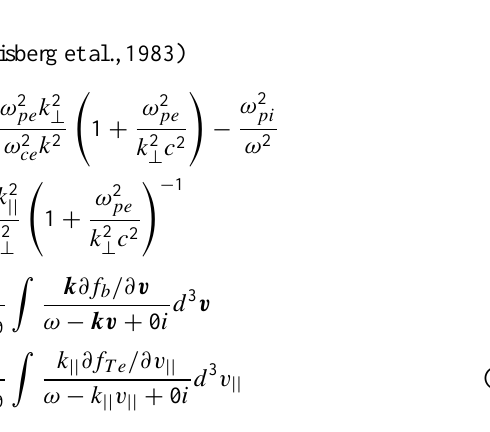
Fig. 12. The ω − k joint spectrum calculated the two parallel electric field components E 13 and E 42 for event